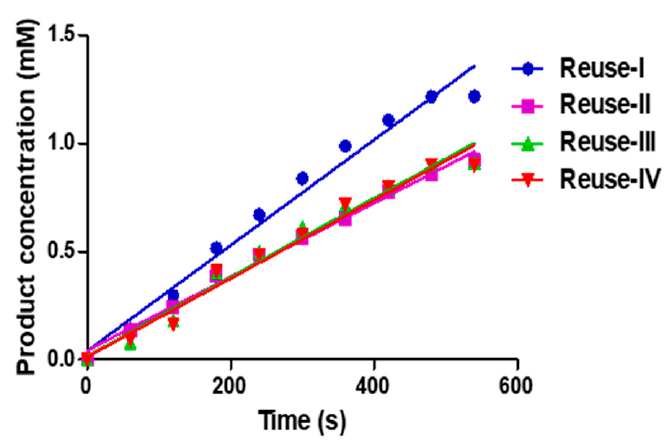
Figure 7. Reusability of PPT/PCIMPs 145–155 .